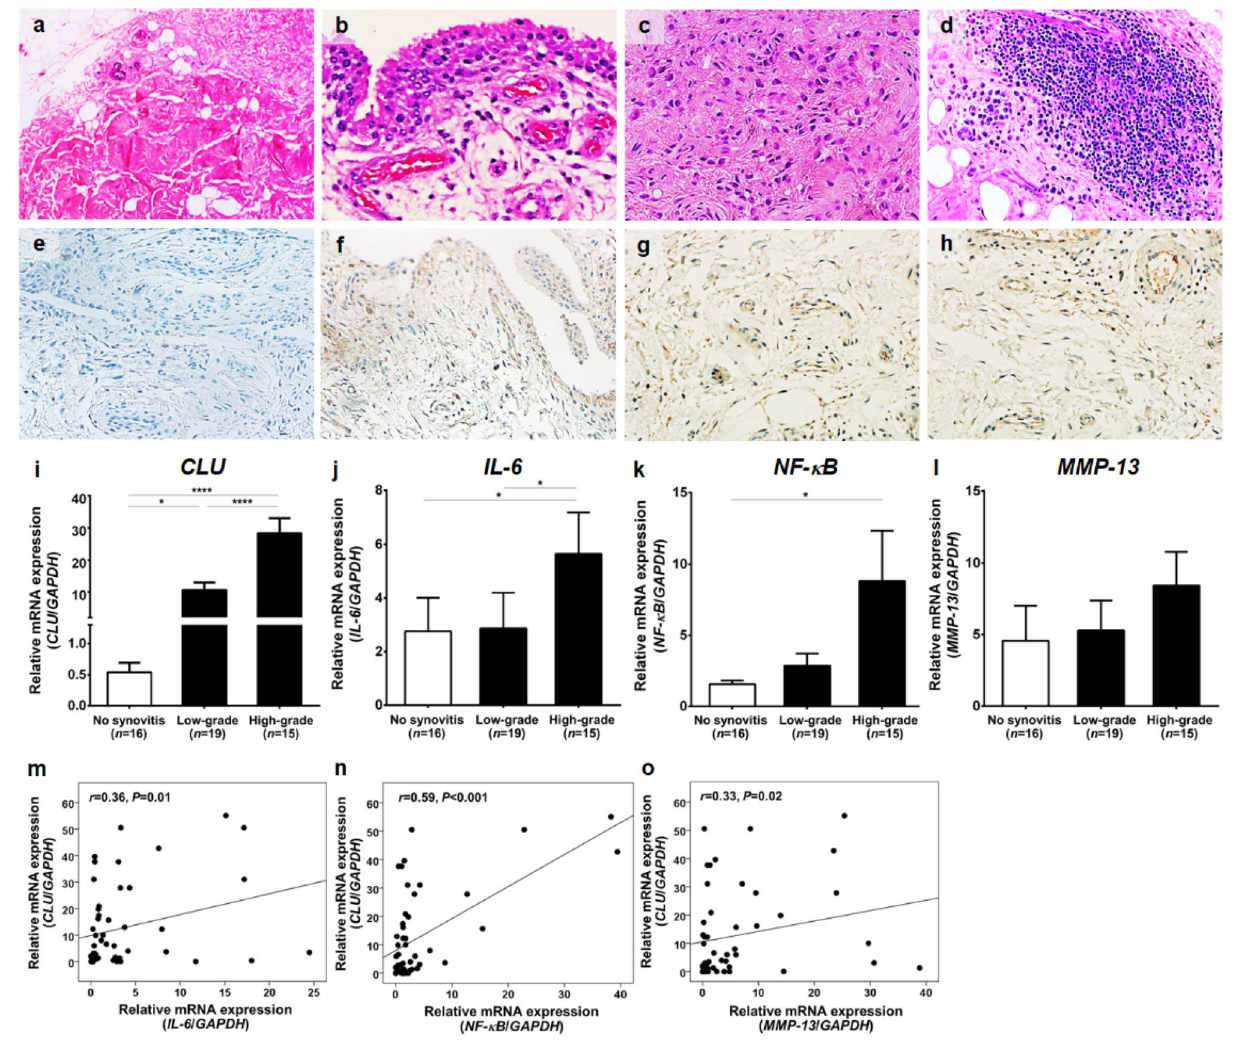
Figure 1. Histopathological staining and CLU mRNA in the synovium of knee OA patients. ( a ) Knee OA synovium without synovitis. ( b ) Knee OA synovium with synovitis showing hyperplasia of synovial lining layer. ( c ) Increased density of stromal cell. ( d ) Inflammatory infiltrate. ( e ) Immunohistological staining displaying scarce expression of CLU protein in knee OA synovium without synovitis. ( f ) CLU protein overexpression in the synovial lining layer of knee OA synovium with synovitis. ( g ) CLU protein overexpression in the sublining layer of knee OA synovium with synovitis, especially in stromal cell. ( h ) CLU protein overexpression in the sublining layer of knee OA synovium with synovitis, especially in inflammatory cells. ( i ) Relative CLU mRNA expression in knee OA synovium. ( j ) Relative IL-6 mRNA expression in knee OA synovium. ( k ) Relative NF-κB mRNA expression in knee OA synovium. ( l ) Relative MMP-13 mRNA expression in knee OA synovium. ( m ) Positive association of CLU with IL-6 . ( n ) With NF-κB . ( o ) With MMP-13 . * P < 0.05, **** P < 0.0001 for comparisons among knee OA with different groups with regard to synovitis